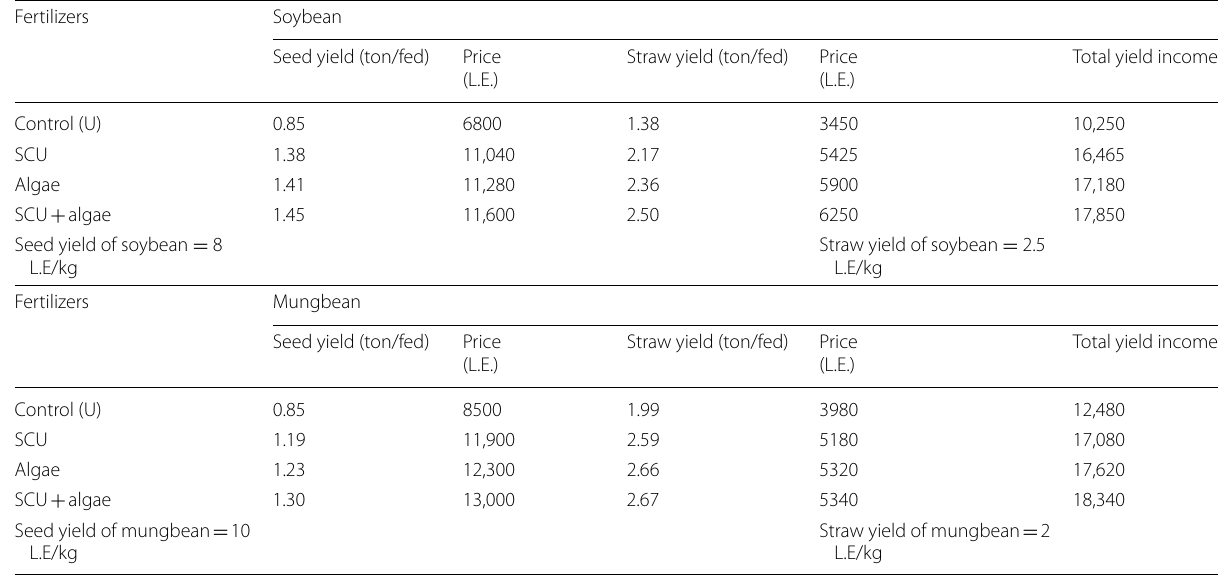
Table 10 Economic feasibility of algae and sulfur-coated urea fertilizers on yield of soybean and mungbean. (Average of two years) Fertilizers Soybean Seed yield (ton/fed) Price